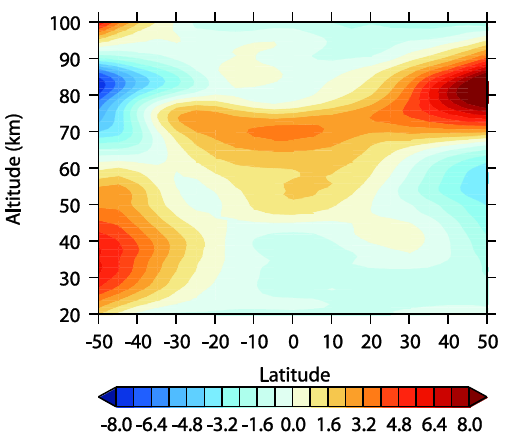
Fig. 7. Percentage of relative differences using 9 year data. Figure 7. Percentage of relative differences using 9-year data. 426